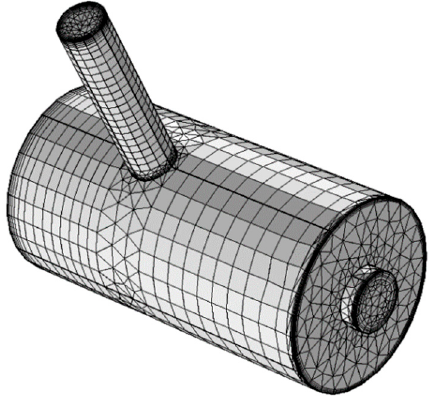
Figure 4. The resonator mesh (22,451 elements).